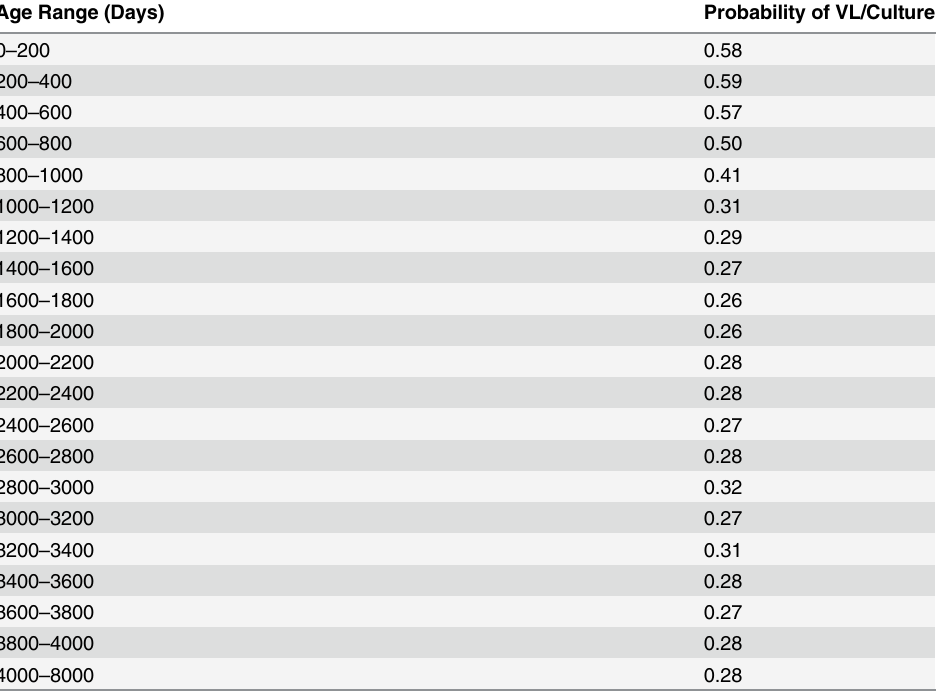
Table 2. Age strati fi ed probability of reactors with visible lesions/culture positive ( P VL ( ɑ